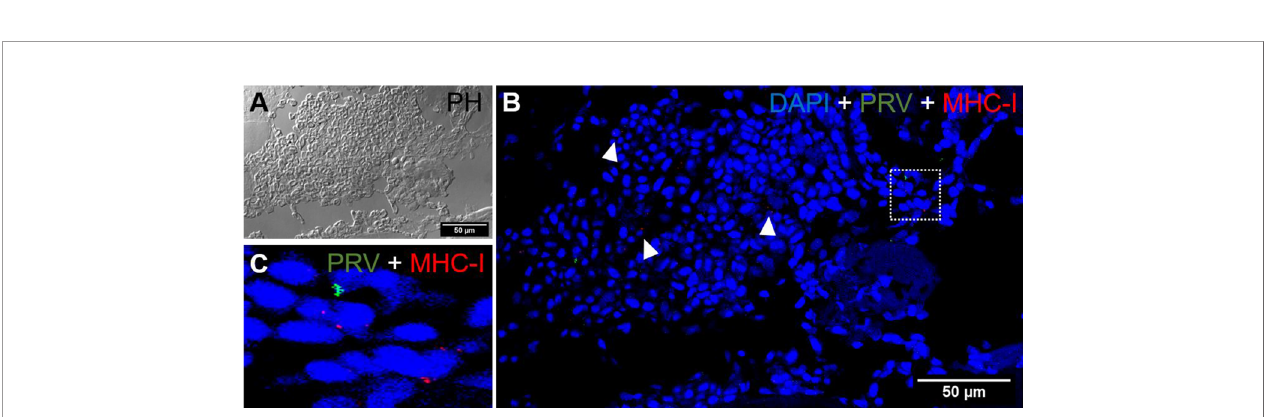
FIGURE 7 | Fluorescent in situ hybridization of PRV-1, CD8 a and GzmA in red focal changes. (A) Phase contrast image showing a bleeding area with a large aggregation of blood cells. (B) Merged image of PRV (green), CD8 a (red) and GzmA (purple). Localization of PRV-1 in CD8+ cell (dotted rectangle at right top) and co-expression of granzyme A in CD8 + T cells (dotted rectangle in left bottom). Individual T cells detected expressing granzyme A speci fi c transcripts (arrowhead) along with other CD8 cells (arrow). Nuclei DNA stained with DAPI (blue) (C) Magni fi ed image of CD8+ and GzmA co-expression from dotted square in image (B) Scale Bar = 50